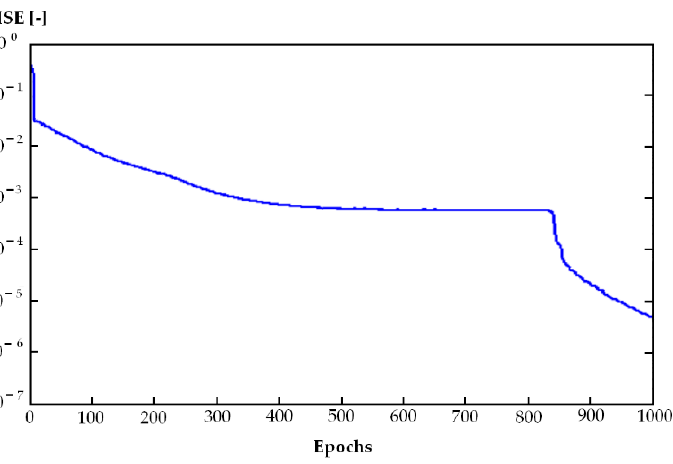
The number of learning epochs ranged from 500 to 1000 (Figure 4).